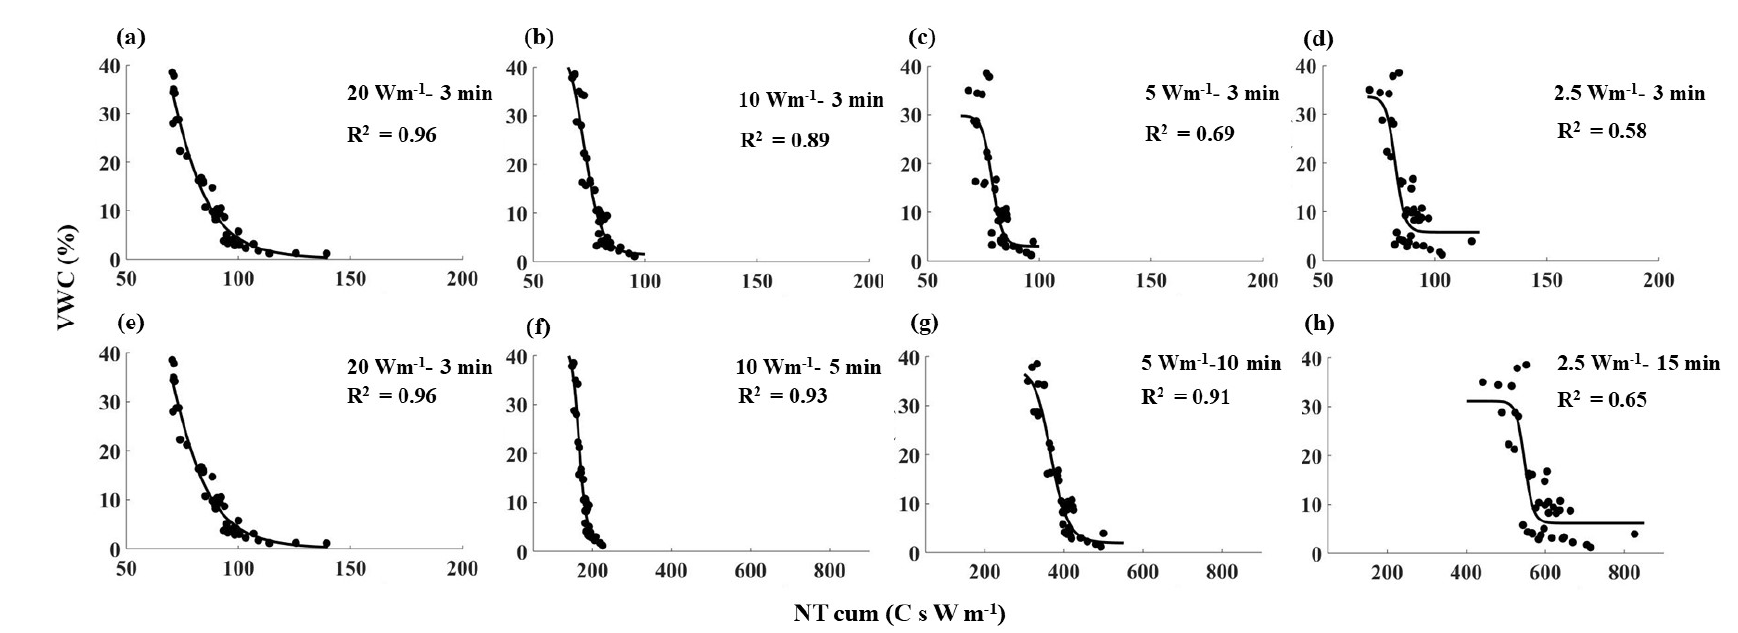
Figure 6. NT cum as a function of VWC for all the heating strategies tested in sandy loam soil. The black dots show the observed values, and the black solid lines show the fitted relationships between NT cum and VWC for individual heating strategies. Note: ( a , e ) are similar (20 Wm − 1 –3 min) and are used to compare with the short pulses (along row 1) and with the long pulses (along row 2).